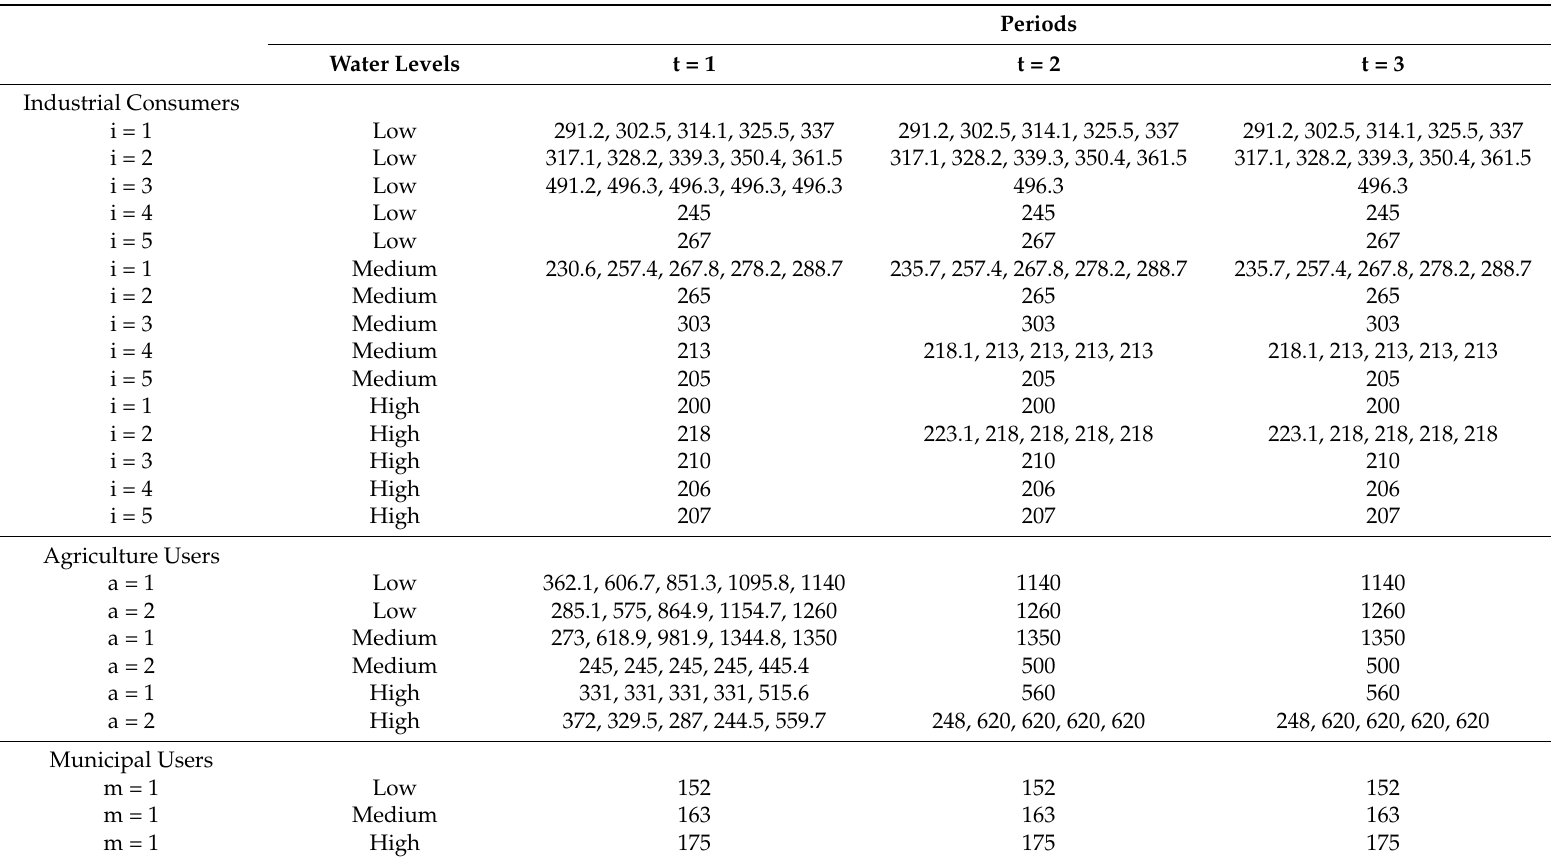
Table 5. Water demands for users under acceptance degrees (10 6 m 3